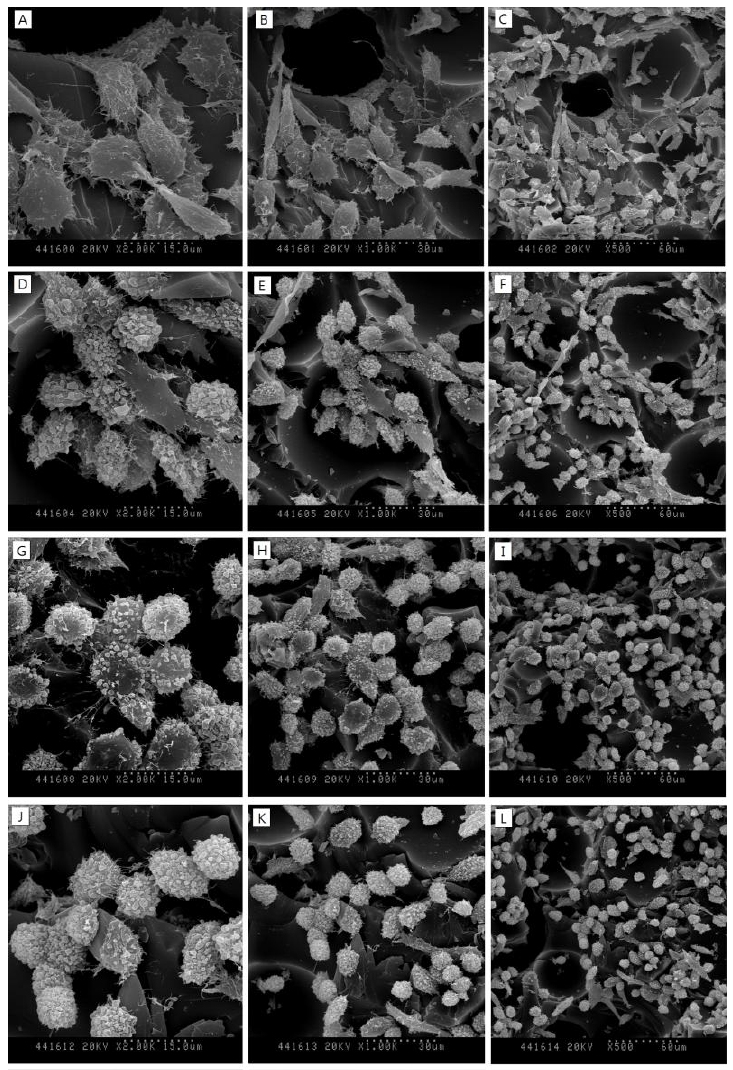
Figure 4. SEM images of cellular changes on 40-pcf polyurethane discs with different phenol concentration. ( A – C ) Negative control (2000×, 1000× and 500×); ( D – F ) Optibond all-in-one (2000×, 1000× and 500×); ( G – I ) Adper easy bond (2000×, 1000× and 500×); ( J – L ) Clearfil S 3 bond (2000×, 1000× and 500×); ( M – O ) G-bond (2000×, 1000× and 500×); ( P – R ) Bond force (2000×, 1000× and 500×); ( S – U ) Futurabond DC (2000×, 1000× and 500×) on the 40-pcf polyurethane disc. The self-etch adhesives changed cell morphology with globular shape or torn surface, whereas L-929 cells freely extended their branches along the pores in the negative control ( A – C ). Especially, each 2000× magnification showed cellular destruction and cracks